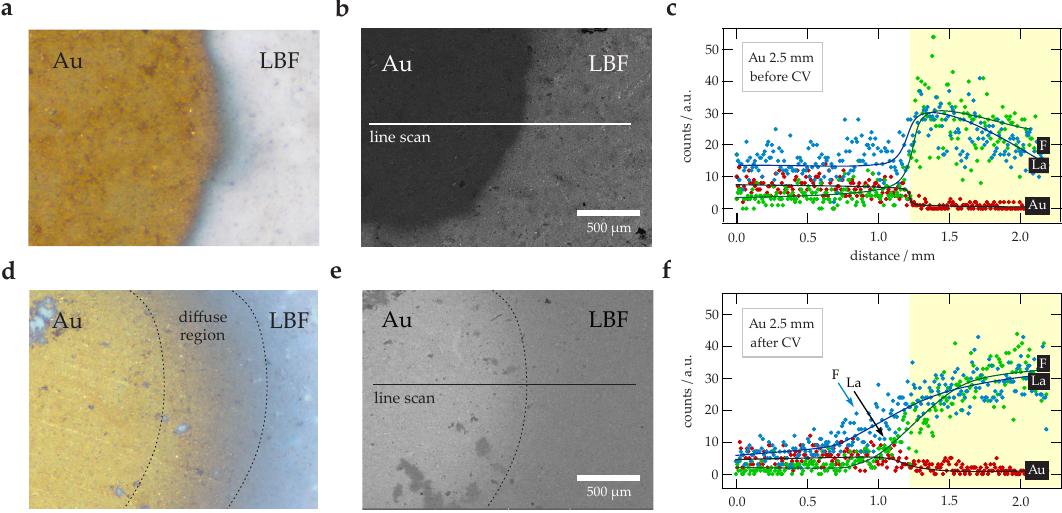
Figure 5. ( a ) Digital light microscopy image of a sample pellet with Au working electrode ( d = 2.5 mm) before the CV measurements were carried out. ( b ) SEM image (SE detector) of the sample pellet with the Au working electrode before CV. The horizontal line indicates the run of the EDX line scan. ( c ) EDX line scan across the surface of the pellet, as depicted in ( b ), for the elements F, Au and La. The lines are only a guide to the eye. ( d ) Image taken by digital light microscopy of the cell after CV. ( e ) SEM image (backscattered electron (BSE) detector) of the cell with Au electrodes after the CV measurements. The horizontal line indicates the run of the EDX line scan. ( f ) EDX line scan across the surface of the pellet, as depicted in (e), for the elements F, Au and La. The lines serve as a guide to the eye. The corresponding CVs of the sandwich cells with Ni as electrode material are shown in Figure